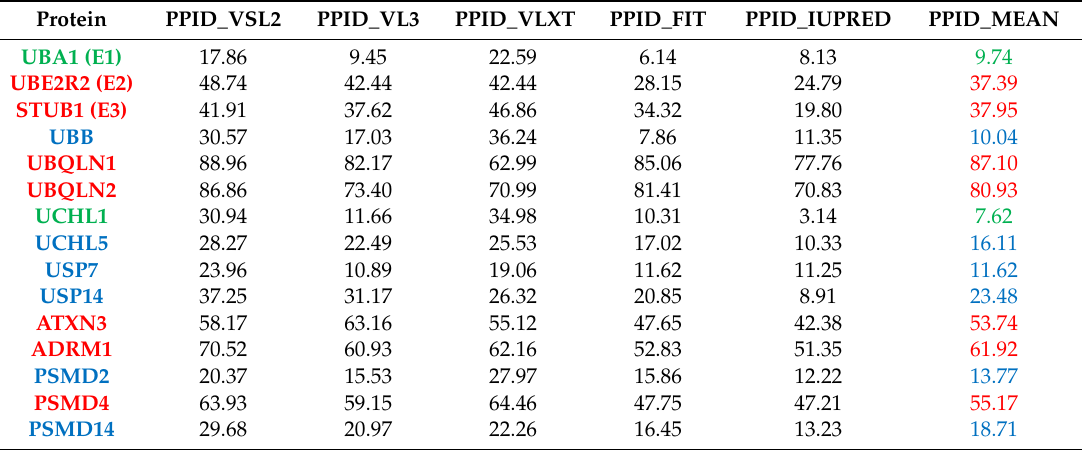
Table 2. Predicted percentage of intrinsic disorder (PPID) in the proteins of UPS. Protein PPID_VSL2 PPID_VL3